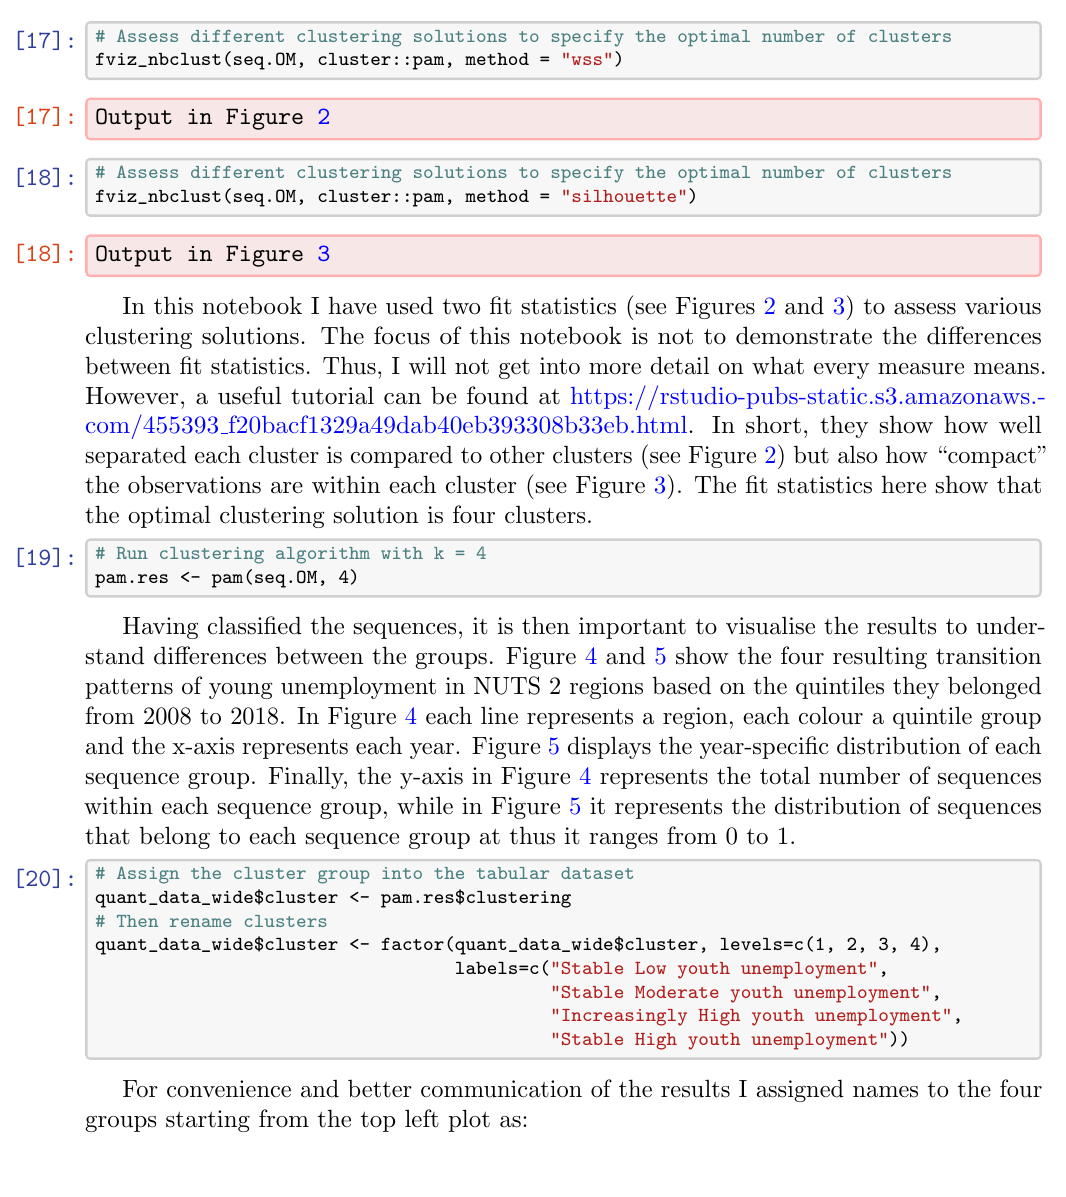
Figure 3: Average silhouette width to access optimal clustering